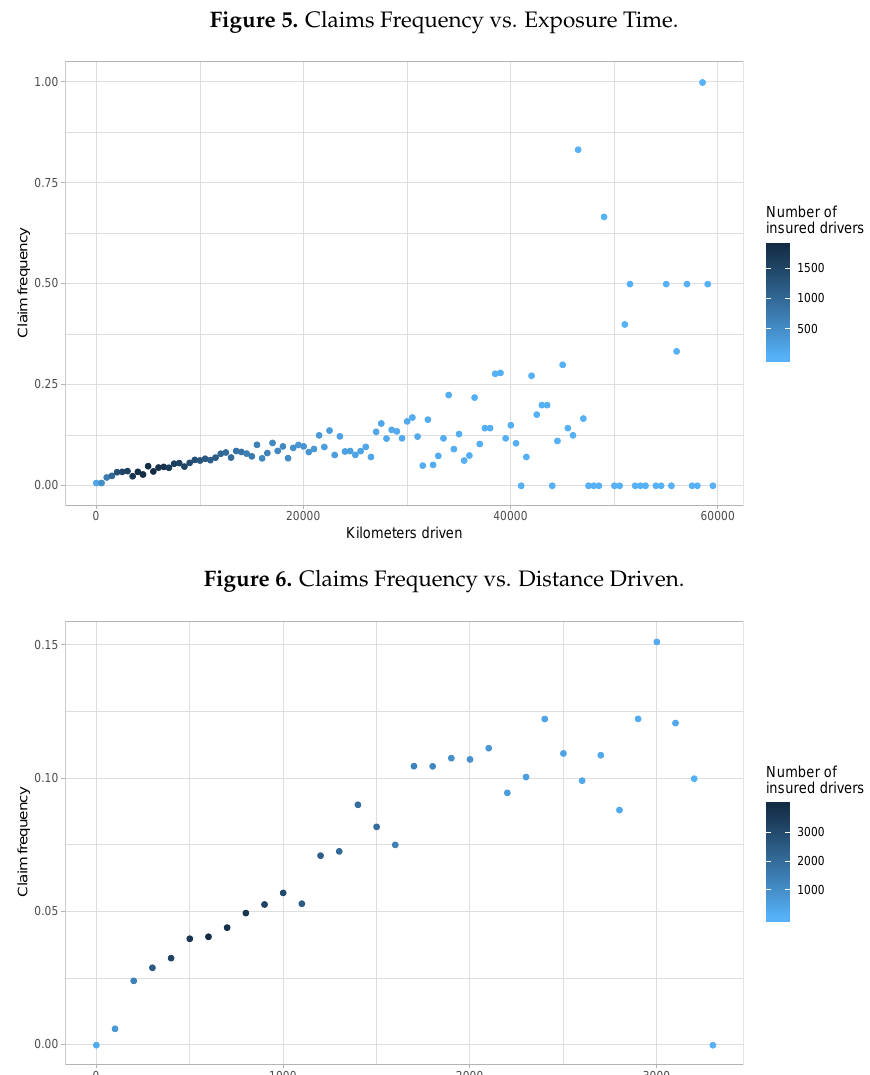
Figure 7. Claims Frequency vs. Number of